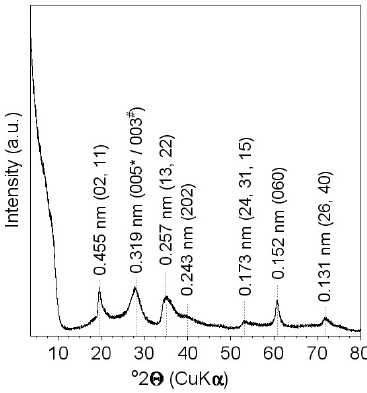
Figure 1. Powder pattern of the clay fraction <2 µm. In addition to the hkl reflections one 001 reflection of the interstratification contribution from (*) saponite and ( # ) turbostratic talc could be detected.